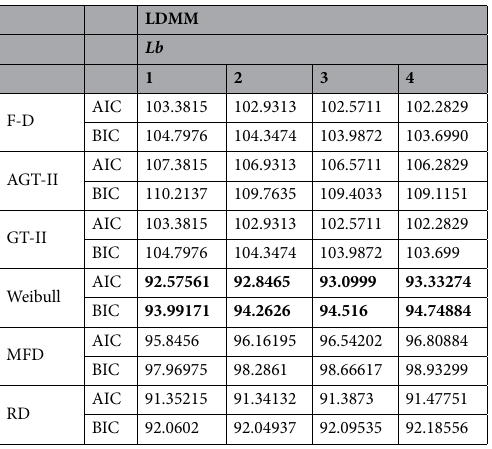
Table 7. Akaike information criteria (AIC) and (BIC) for LDMM.